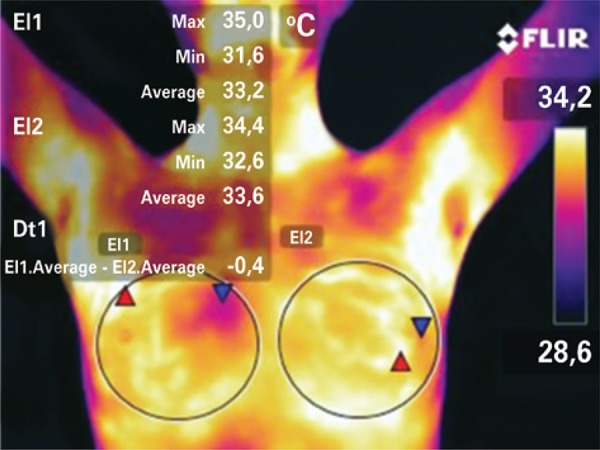
Termografia das mamas de uma das voluntárias, no 9o dia do ciclo menstrual, demonstrando posicionamento de incidência anterior, com delimitação das áreas de interesse para medida das temperaturas máxima, mínima e média, bem como gradiente térmico entre elas